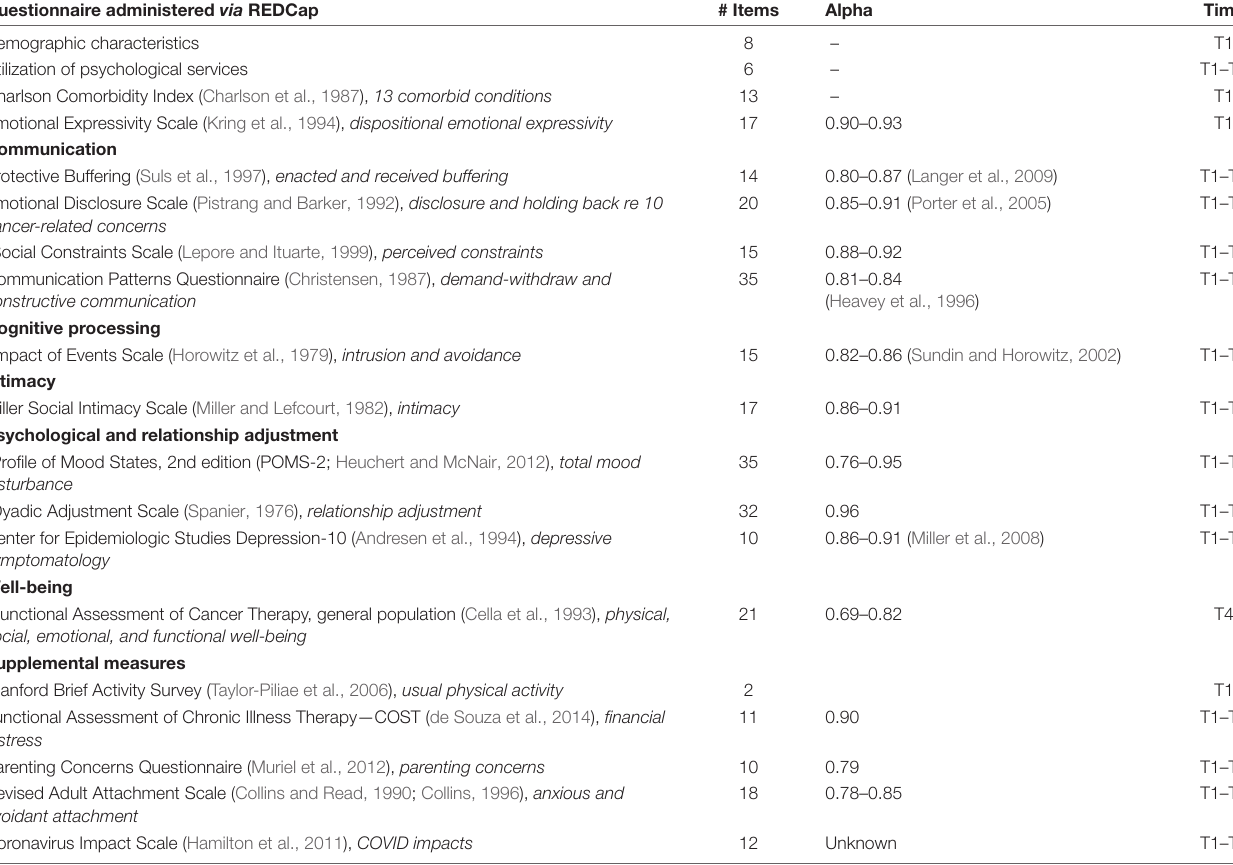
TABLE 1 | Questionnaire-based assessments administered via REDCap: Key constructs, internal consistency, and administration time point. Questionnaire administered via